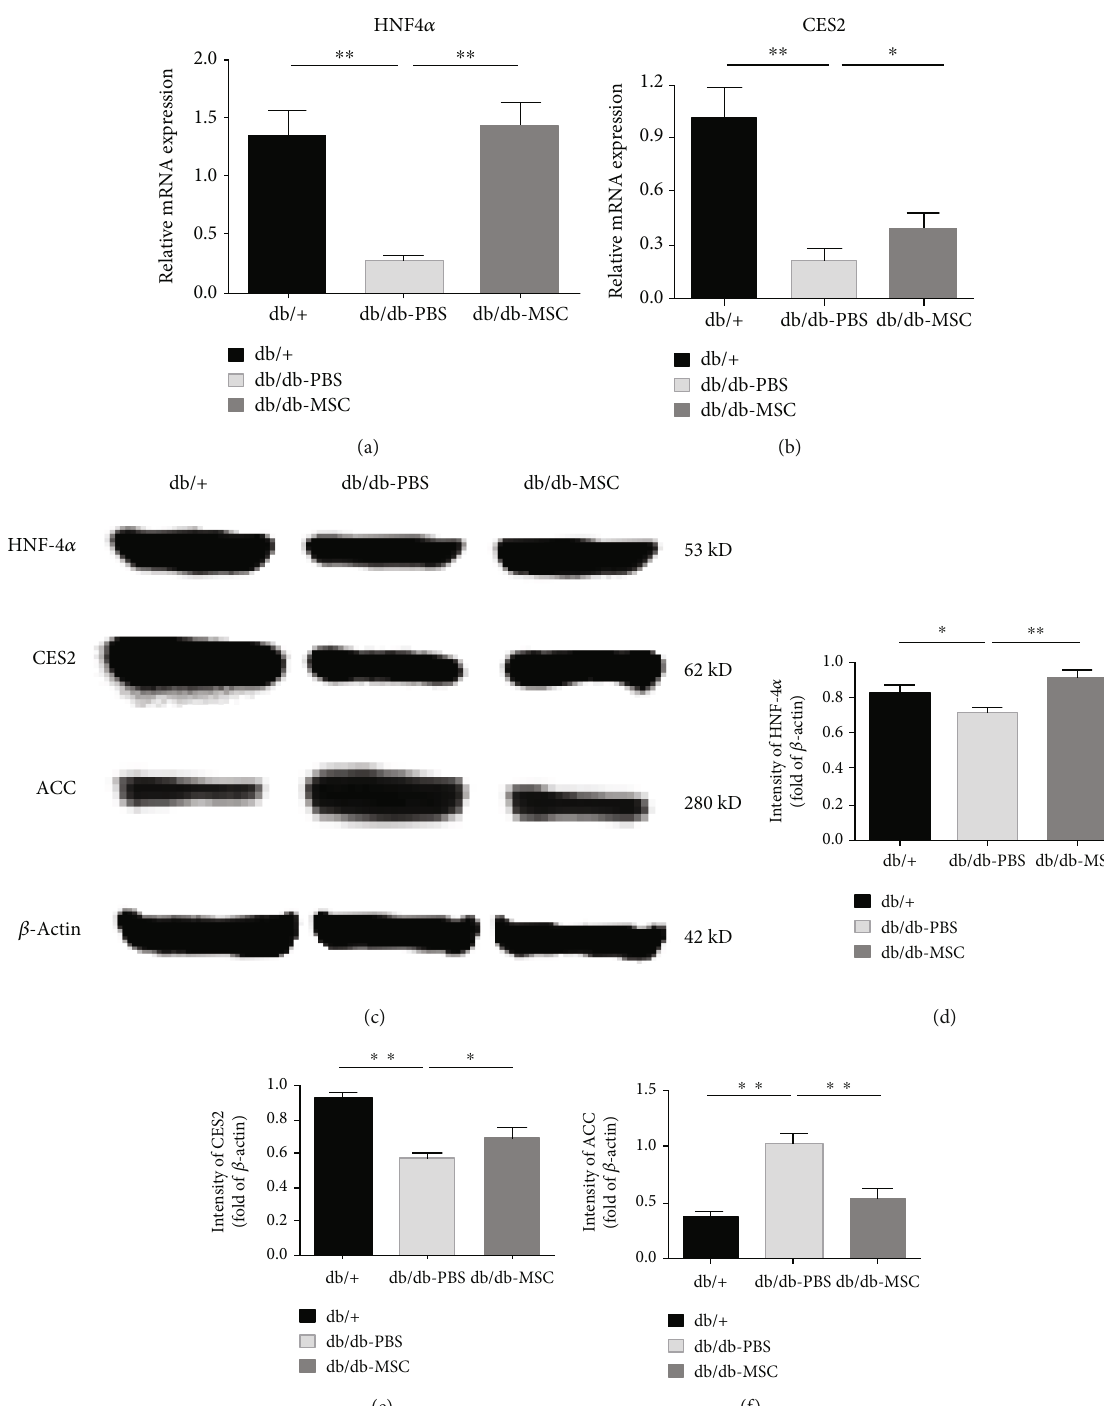
Figure 6: Human UC-MSC infusions upregulated the HNF4 α and CES2 expressions. Transcript levels of HNF4 α (a) and CES2 (b) in the livers of the indicated groups assessed by qRT-PCR. (c) Protein levels of HNF4 α , CES2, and ACC assessed by western blot ( β -actin served as the loading control). (d – f) Statistical analysis of HNF4 α , CES2, and ACC protein levels. Each experiment was repeated three times, and typical pictures were shown. Data are expressed as means ± SD . ∗ p < 0 : 05 ; ∗∗ p < 0 : 01